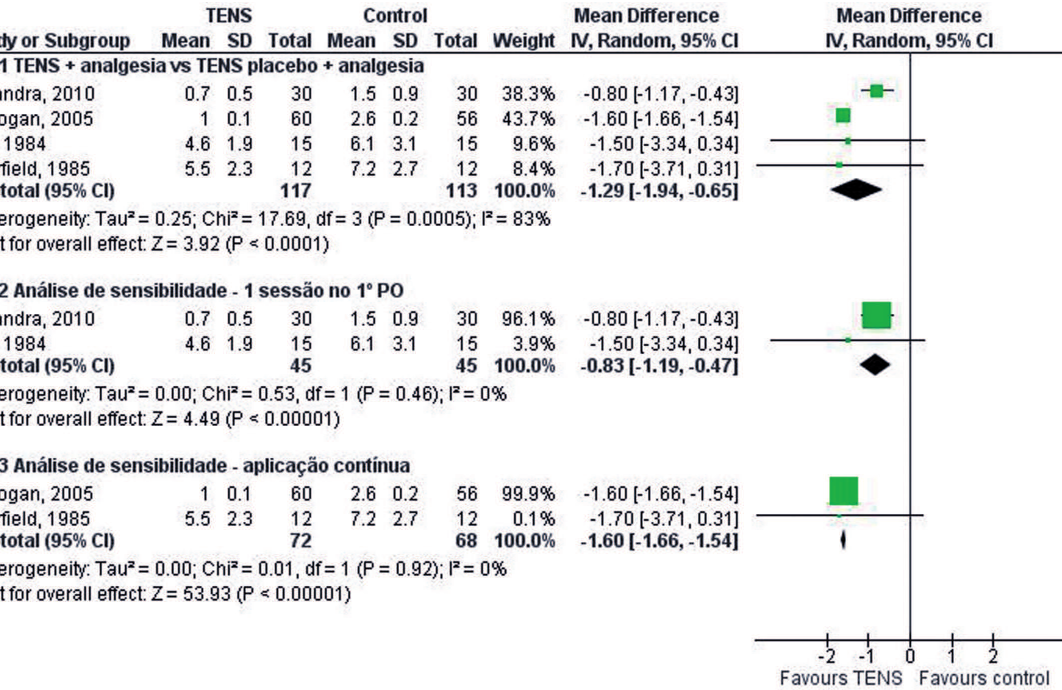
Fig. 2 – Análise da dor referente aos estudos que realizaram cirurgia com abordagem por toracotomia posterolateral: comparação da TENS + analgesia vs. TENS placebo + analgesia. TENS = estimulação elétrica nervosa transcutânea